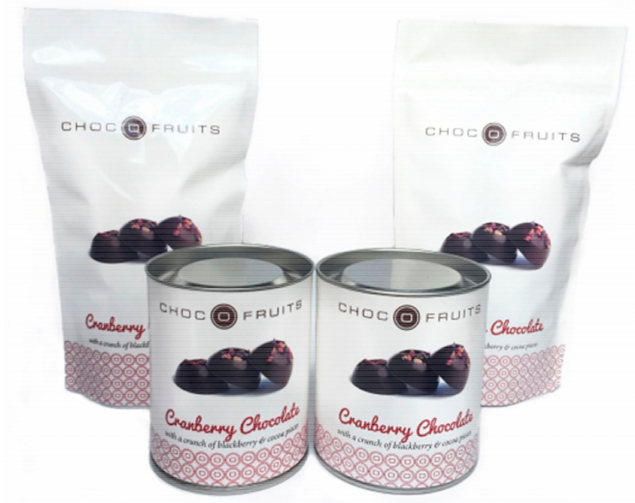
Figure 2. Stimulus material used in study 1: glossy packaging (left), matte packaging